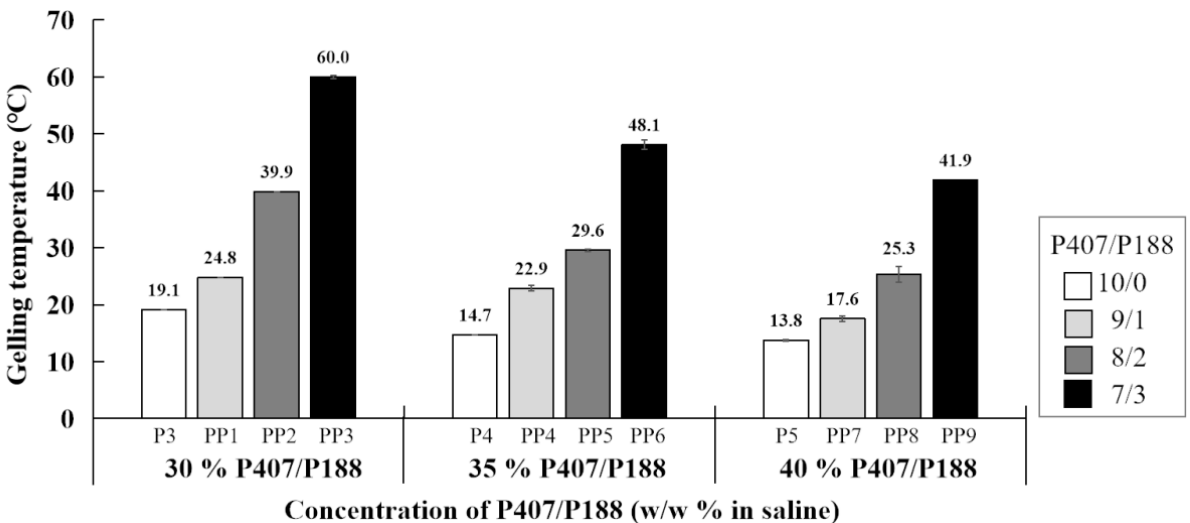
Figure 2. Average gelling temperature of P407/P188-blended hydrogel at different ratios. White bars: P407 only; gray bars: P407/P188 = 9/1; deep gray bars: P407/P188 = 8/2; black bars: P407/P188 = 7/3.